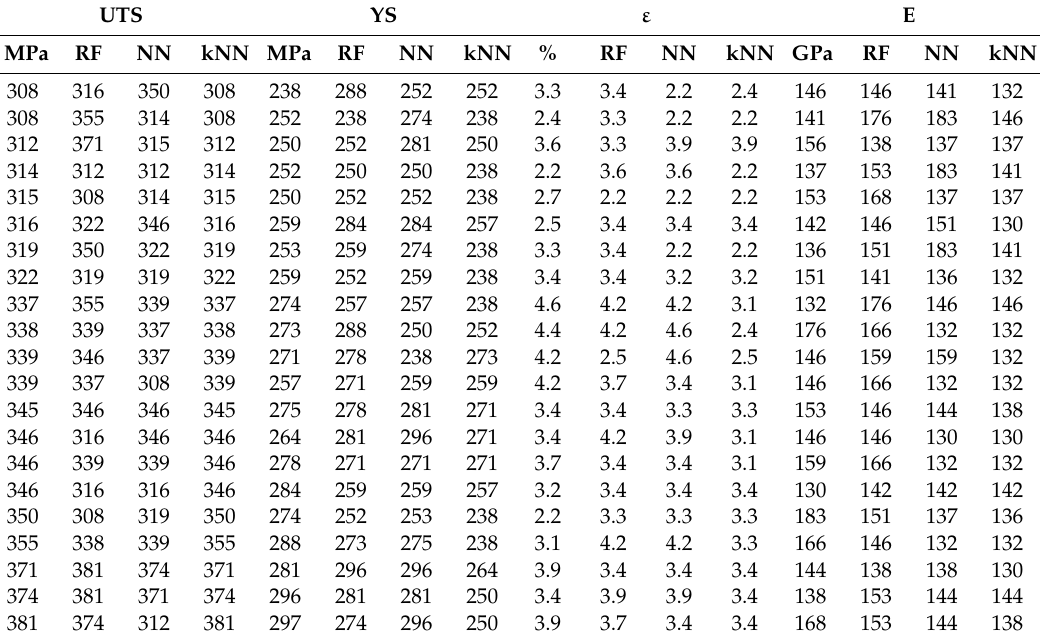
Table A4. Prediction of mechanical properties of Compacted Graphite Iron